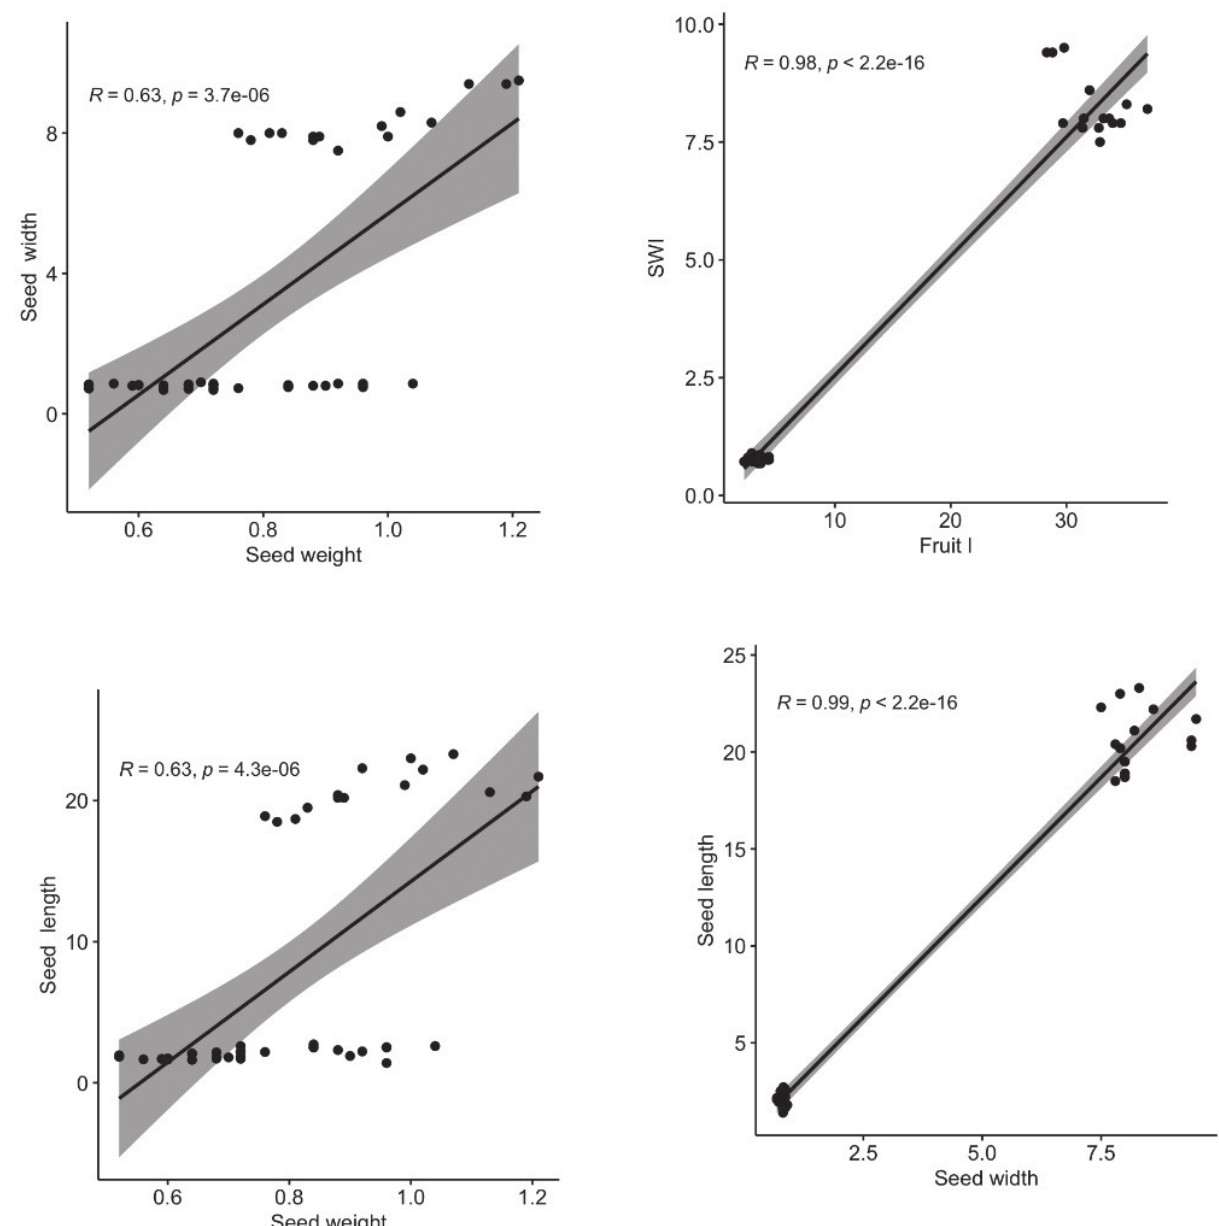
Figure 7. Representative Pearson coefficient of correlation among morphological characters studied in date palm